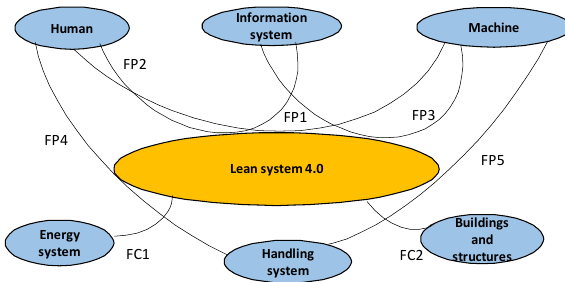
Figure 1. Octopus diagram of our system